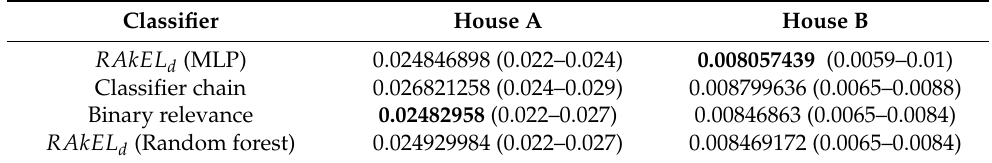
Table 5. Average Hamming loss per classifier (lower is better). Inside the parentheses is the confidence interval (96% confidence). The best value can be seen in bold.